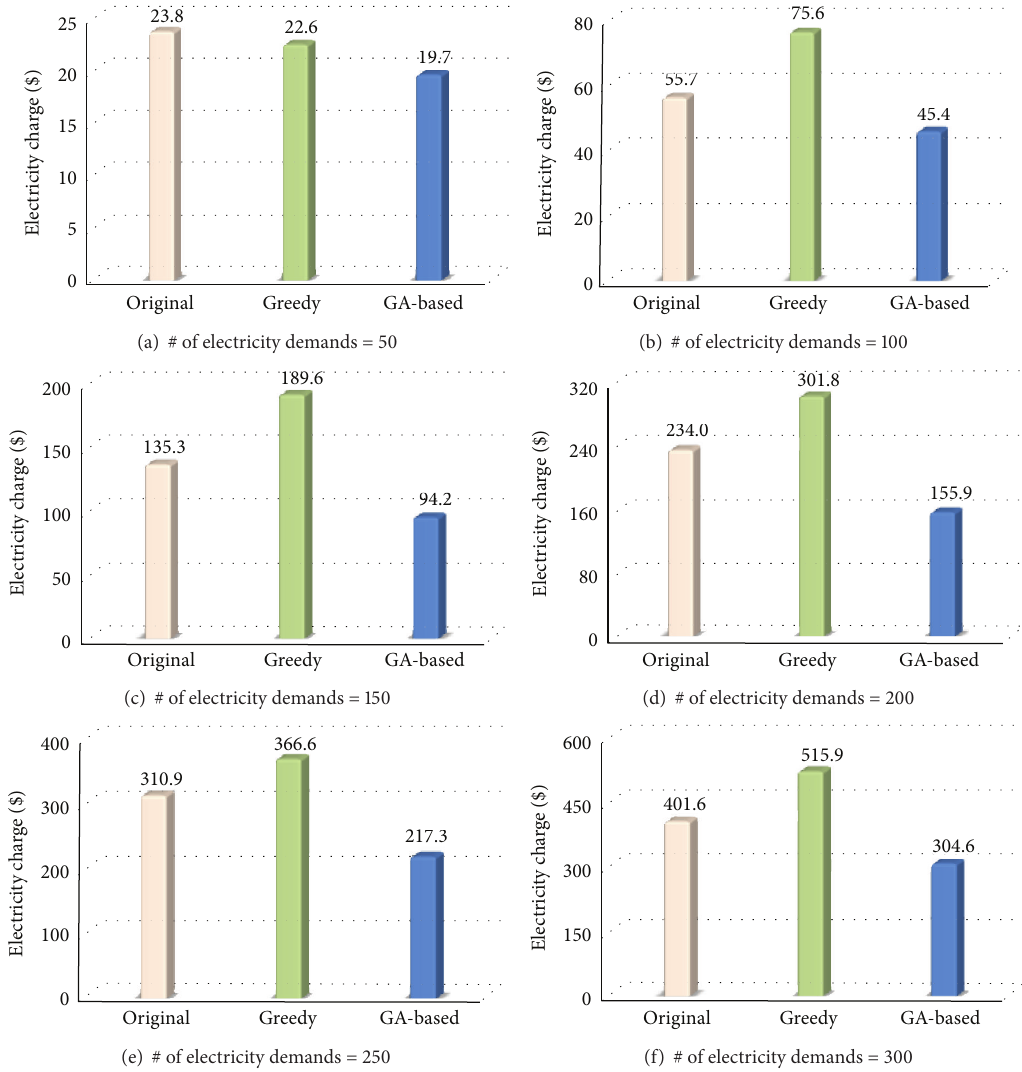
Figure 10: Comparison of electricity